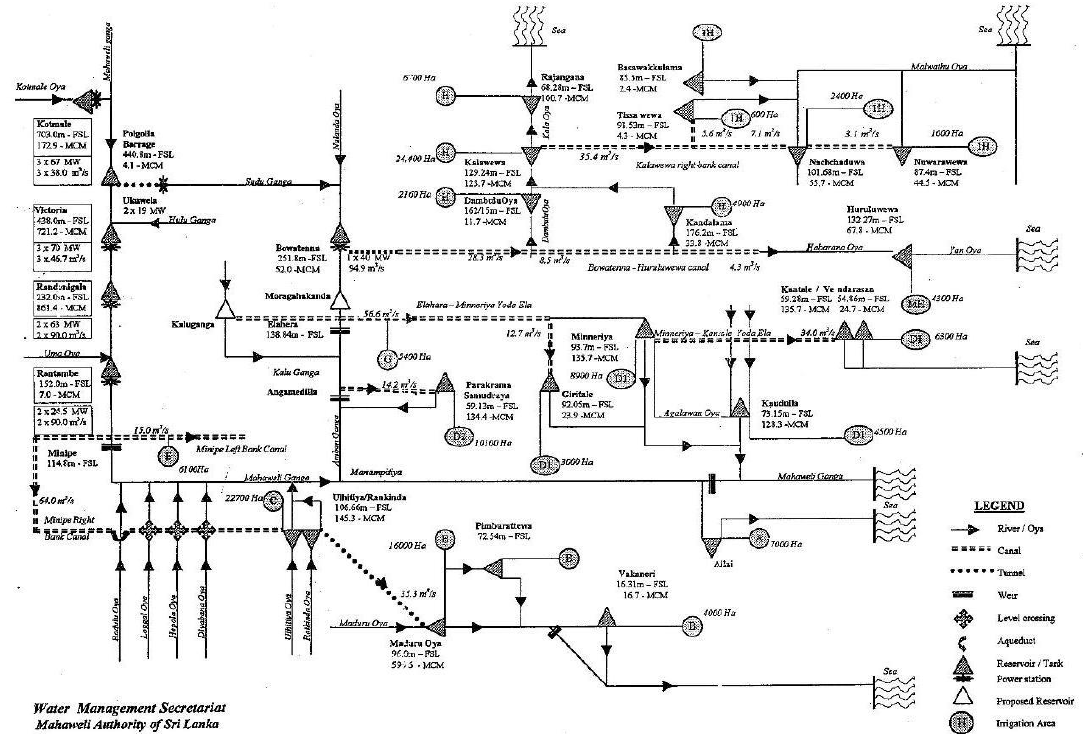
Figure 5. Layout of a cross section of the dam, tank and canal network for irrigation as created by the Mahaweli Development Project.